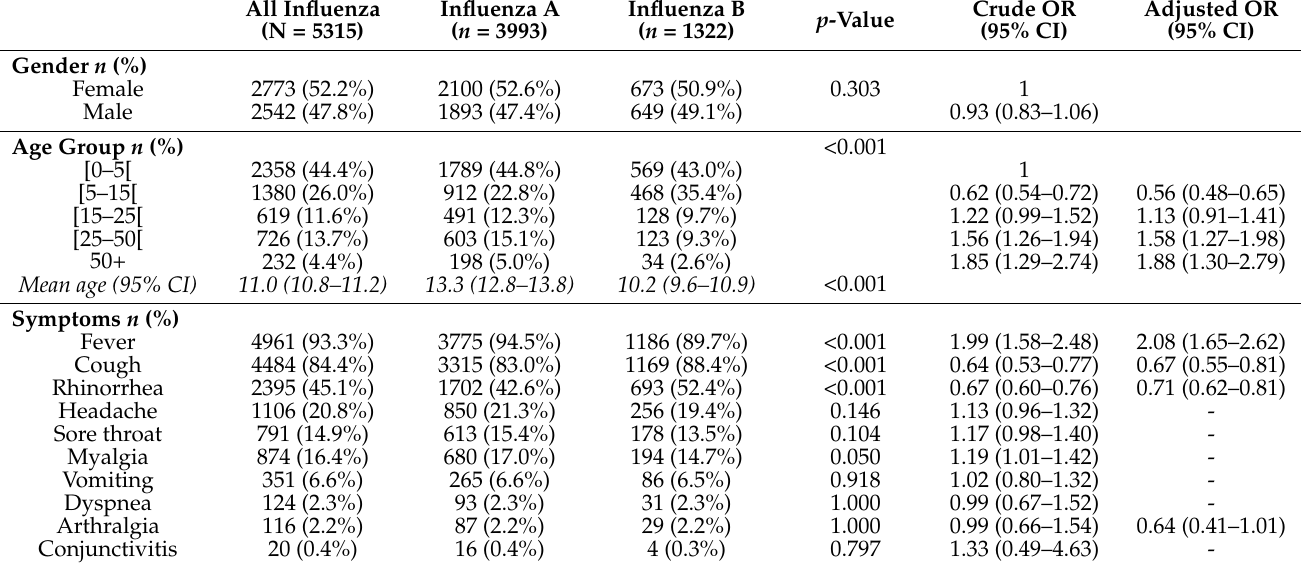
Table 2. Characteristics of patients according the type of influenza virus detected. Senegal 2010–2019.